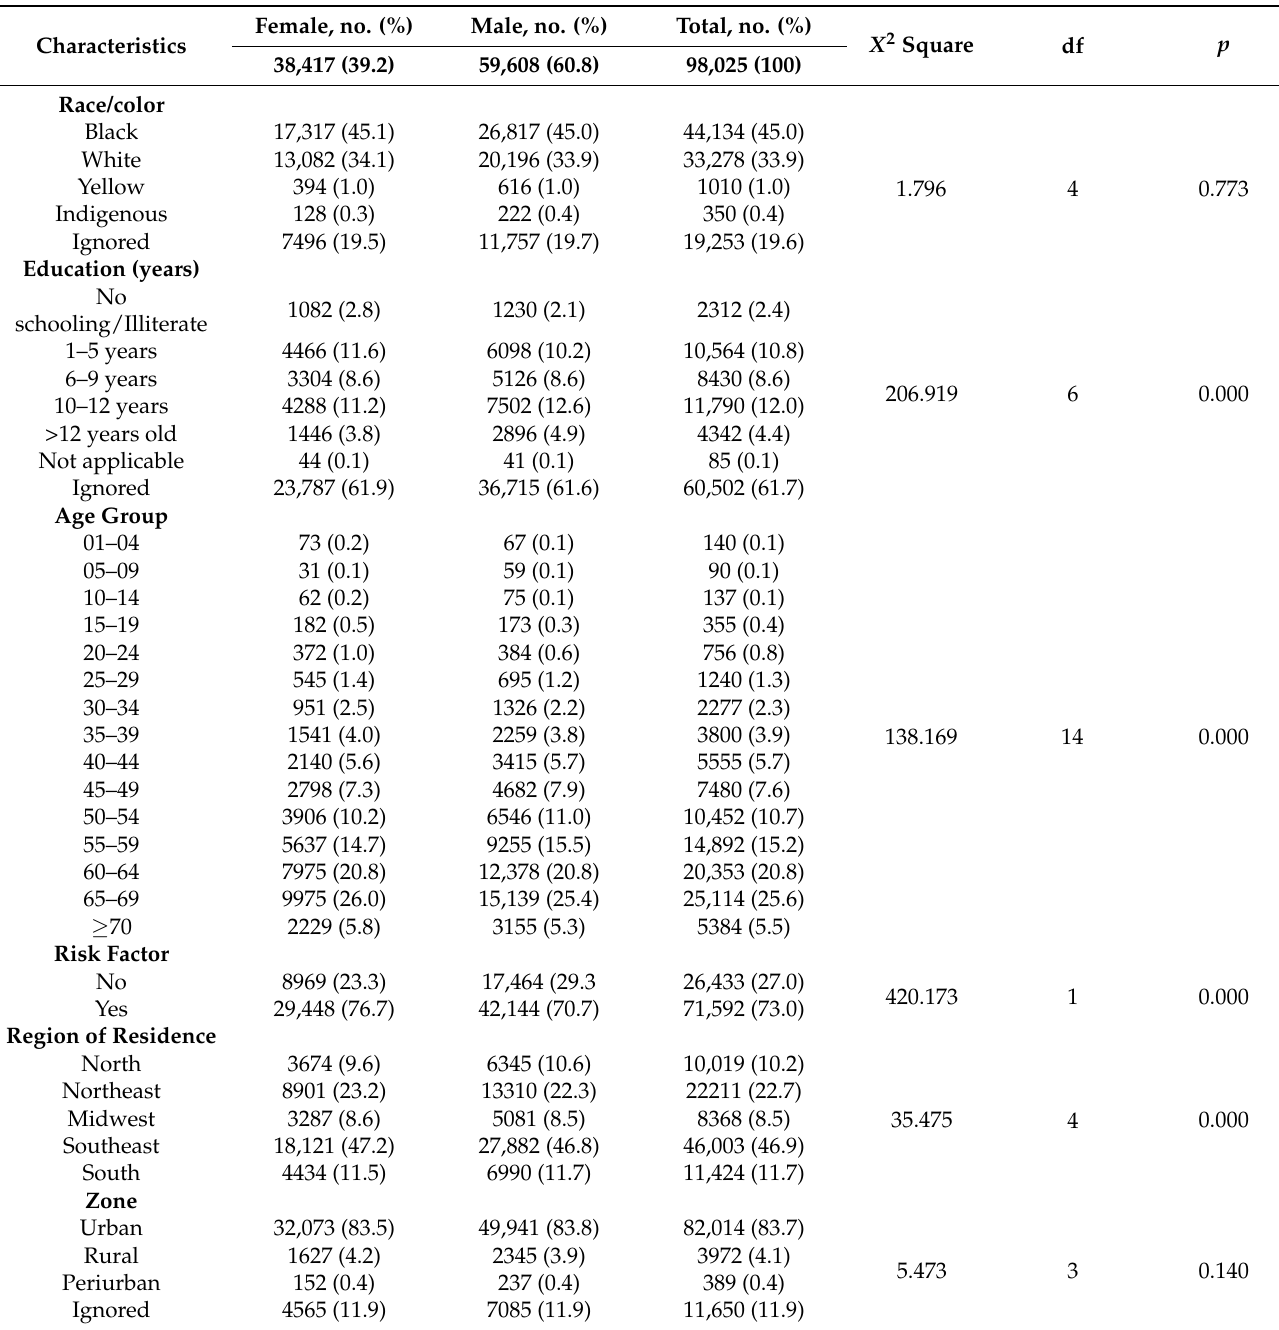
Table 1. Distribution of SARS deaths due to COVID-19 in Brazil (2020) and proportional description according to sociode- mographic